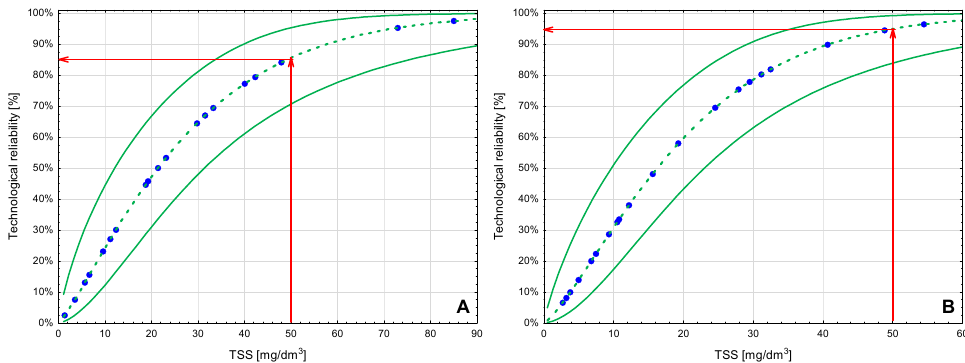
Figure 3. Weibull cumulative distribution functions and the technological reliabilities determined for TSS (( A )—facility no. 1; ( B )—facility no. 2). Notation: dashed green line—reliability function, continuous green line—confidence intervals, red arrows—probability of achieving the indicators limit in the effluent. Figure 4. Weibull cumulative distribution functions and the technological reliabilities determined for BOD 5 (( A )—facility no. 1; ( B )—facility no. 2). Notation : dashed green line—reliability function, continuous green line—confidence intervals, red arrows—probability of achieving the indicators limit in the effluent.